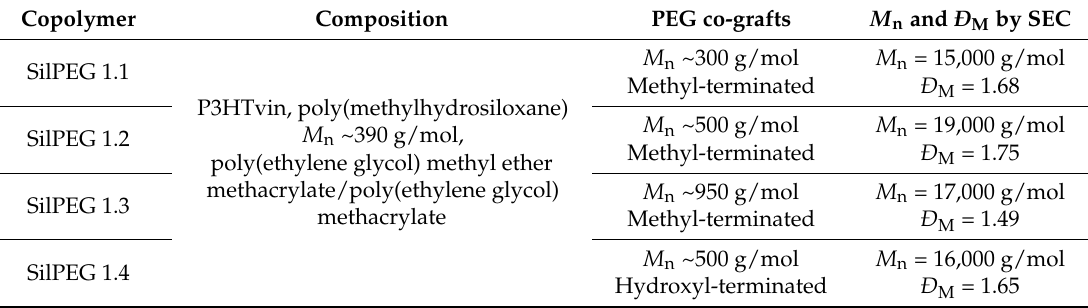
Table 1. Details of the copolymer composition.